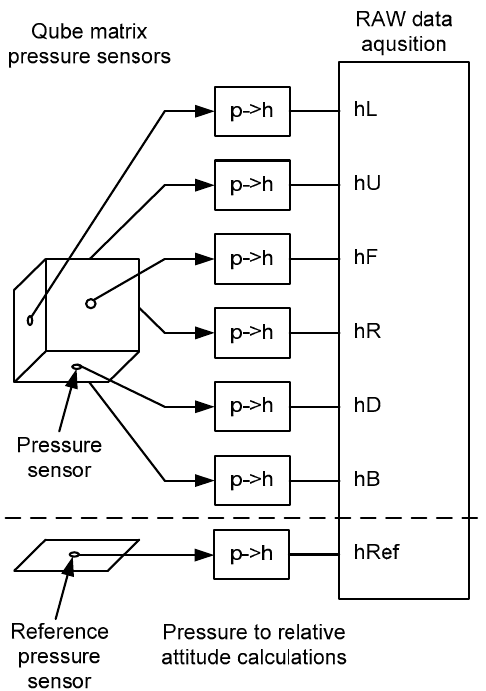
Figure 4. General block diagram of the data acquisition system.